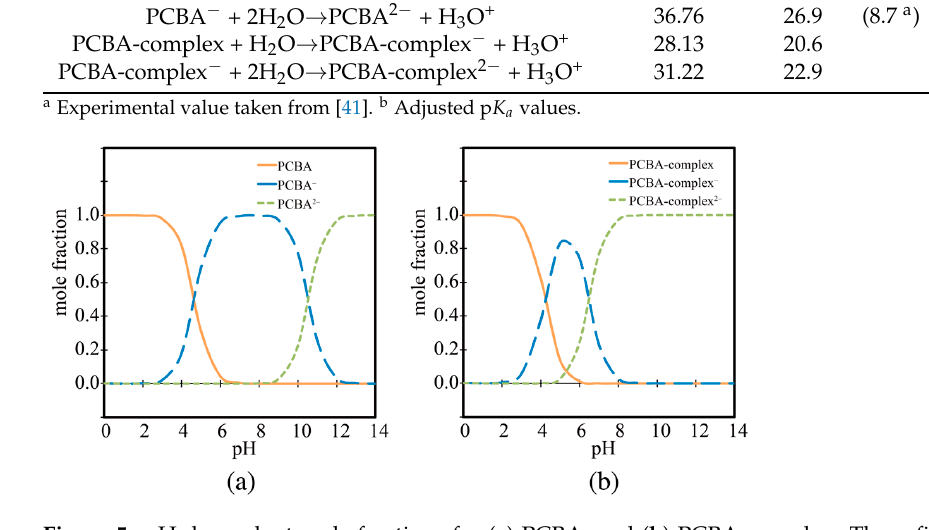
Table 3. Reaction free energies and p K a values for PCBA and its complex. This table is reprinted with permission from [42], Copyright 2016, Elsevier.